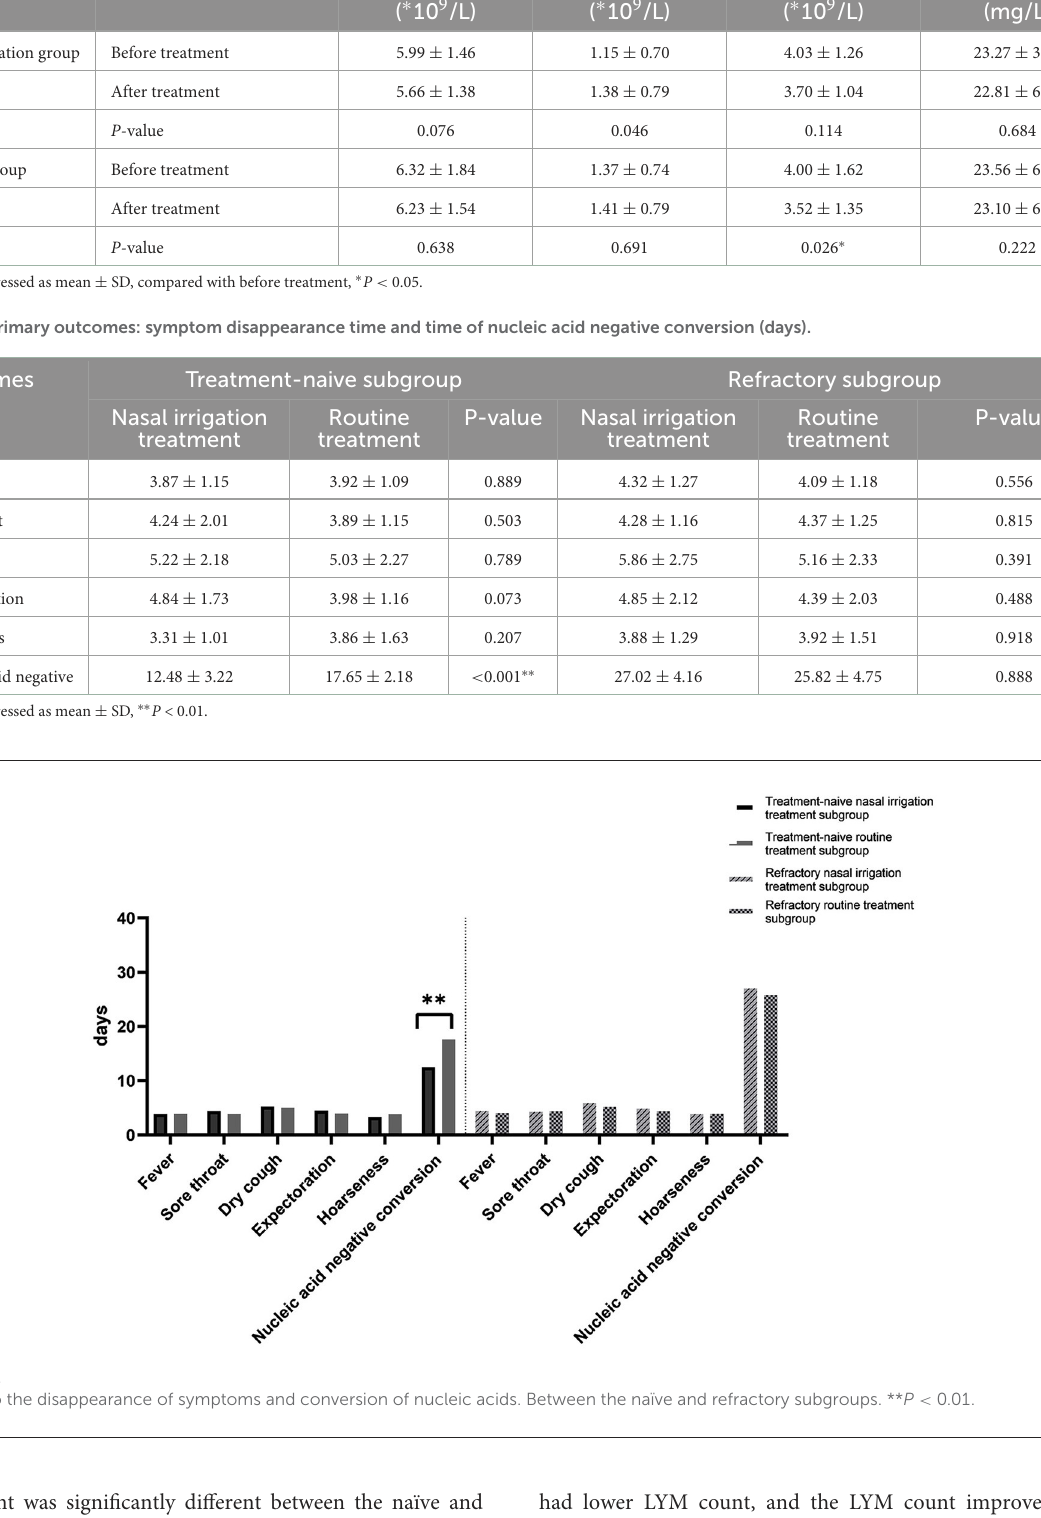
LYM count was significantly different between the naïve and refractory subgroups. The patients in the refractory group